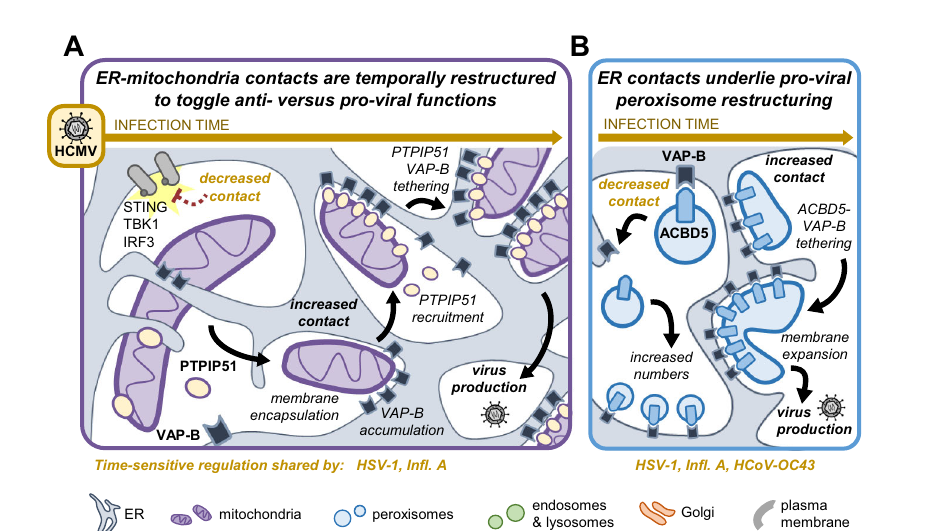
Fig. 6 | ER-mitochondria and ER-peroxisome contacts are required for HCMV- driven organelle remodeling. A Model for ER-mitochondria contact remodeling duringtheHCMVinfectiouscycle.ContactisdecreasedearlytoevadeSTING-TBK1- IRF3 signaling induced by increased ER-mitochondria tethering, a shared function withHSV-1and likelyIn fl .A.Lateininfection,contactisincreasedandrestructured intoER-mitochondriaencapsulations(MENCs)thatrecruitVAP-BandthenPTPIP51, which increase in tethering interactions, and PTPIP51 is required for